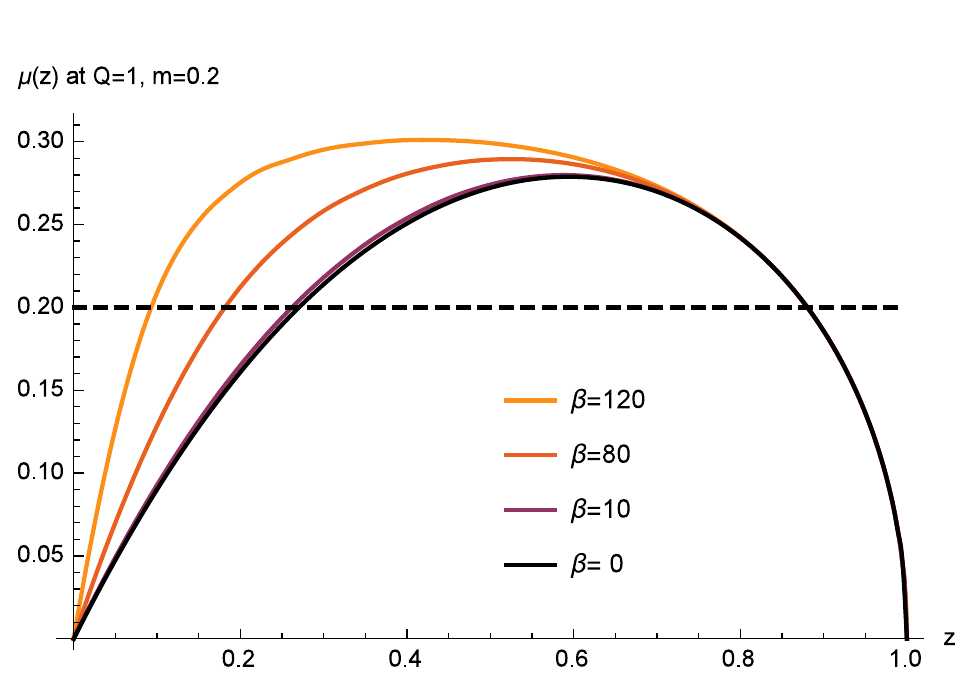
Figure 2 . The chemical potential in an electron cloud model at Q = 1 and m = 0 : 2 for di(cid:11)erent values of (cid:12) . Note that all chemical potentials are equal only beneath the dashed line ( m ) to the right.